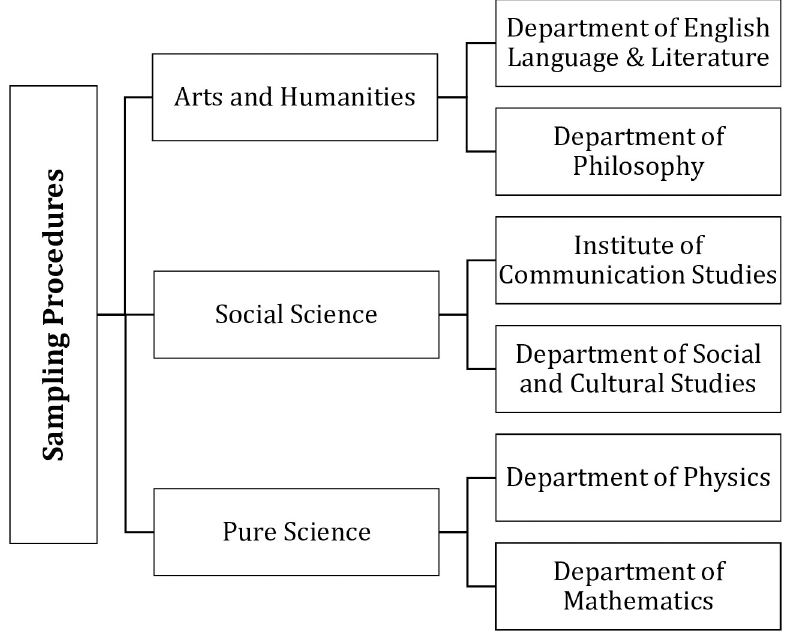
Fig 2. A flow chart of population and sampling